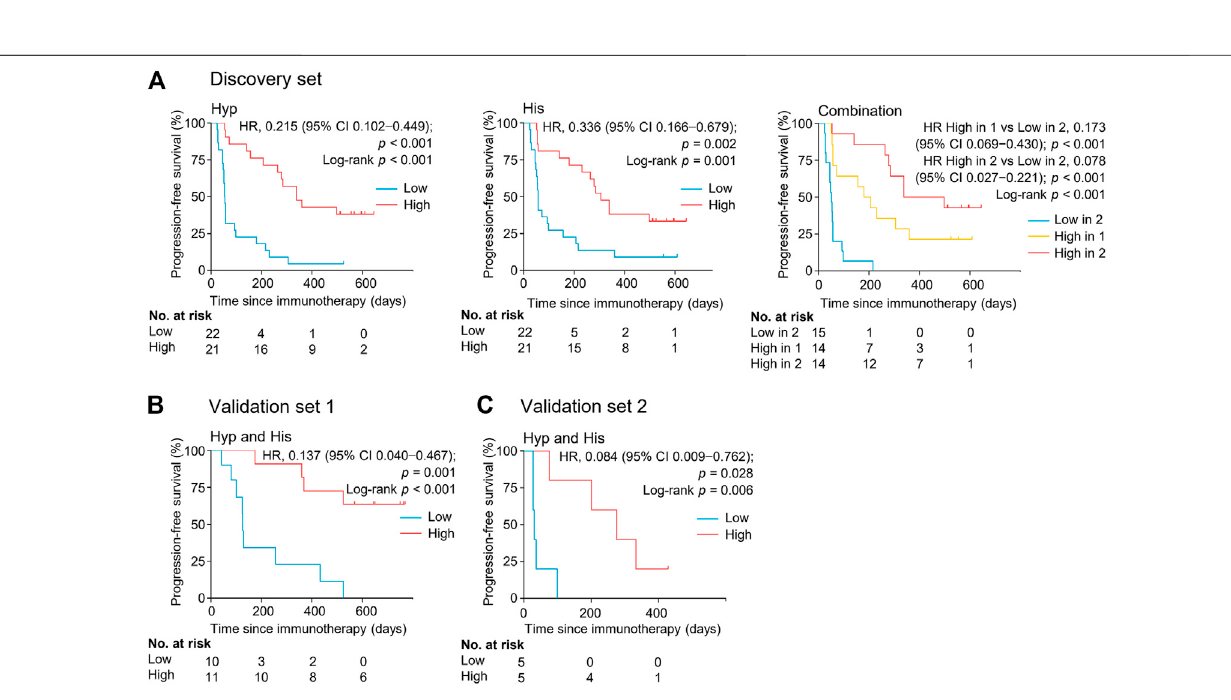
FIGURE 4 | Serum levels of metabolite biomarkers at early on-treatment associate with progression-free survival in the discovery set (A) , validation set 1 (B) , and validation set 2 (C) . Kaplan-Meier analysis for progression-free survival in NSCLC patients by serum levels of hypoxanthine and/or histidine. His, histidine; Hyp, hypoxanthine; HR, hazard